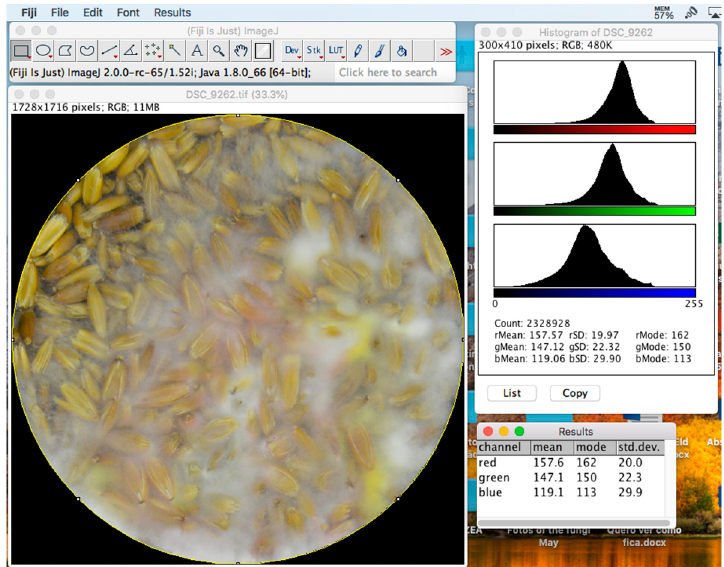
Figure 3. ImageJ toolbox (top left), a photo of heavily contaminated oat grains (bottom left), a color histogram showing distributions of intensities of RGB components in the photo (top right), and the average intensity of each color (bottom right).